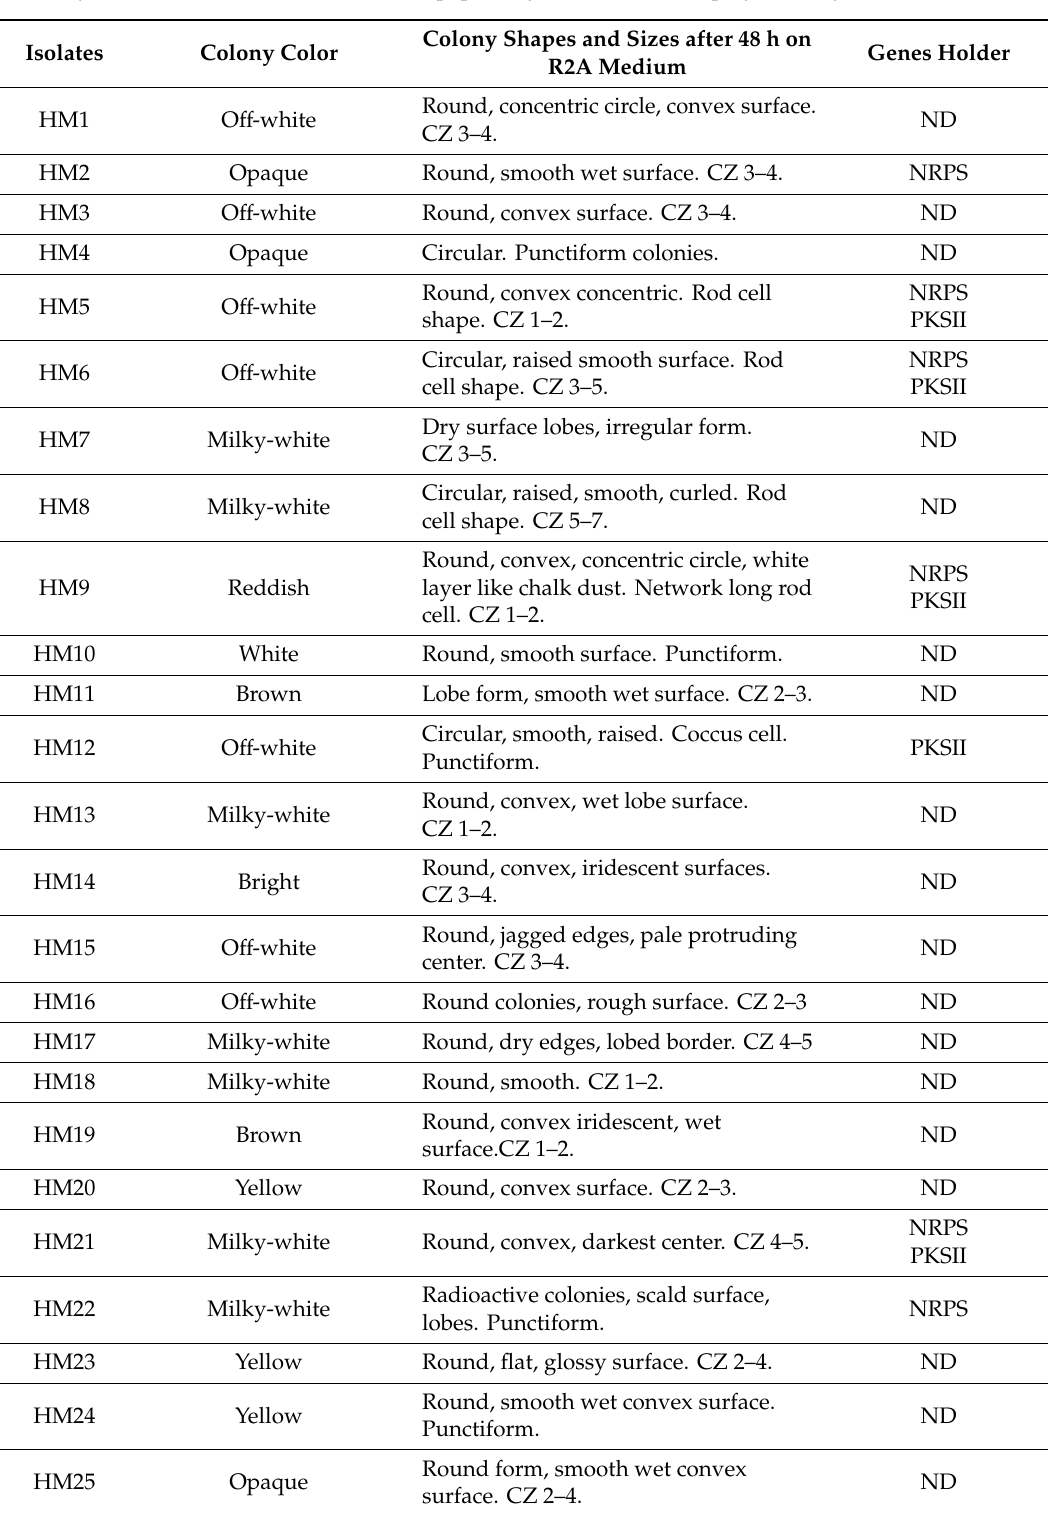
Table 1. List of sponge-associated bacteria with basic characteristics (Notation: ND, not detected; CZ, colony size in mm; NRPS, non-ribosomal peptide synthetases; PKSII, polyketide synthases II).